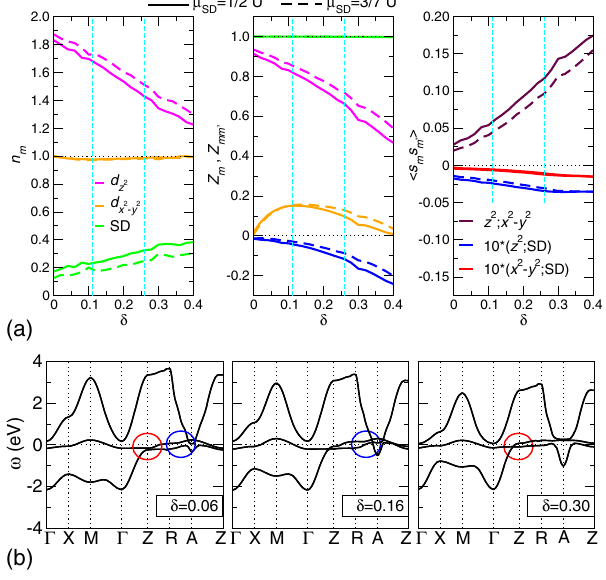
FIG. 10. Evolution of NdNiO 2 many-body electronic structure with hole doping δ , approached by the three-orbital Hamiltonian at U ¼ 7 eV. (a) From left to right: Orbital-resolved occupations, 3 = 7 U QP weights, and local spin-spin correlations for μ SD ¼ U= 2 (solid lines). Cyan dashed lines (dashed lines) and μ SD ¼ mark the occurrence of Fermi-surface reconstructions (see text). 3 = 7 U . Locations for (b) QP dispersions at selected δ for μ SD ¼ the Fermi-surface reconstructions are highlighted by the blue ellipse (for those occurring at δ ¼ 0 . 11 ) and by the red ellipse (for those occurring at δ ¼ 0 . 26